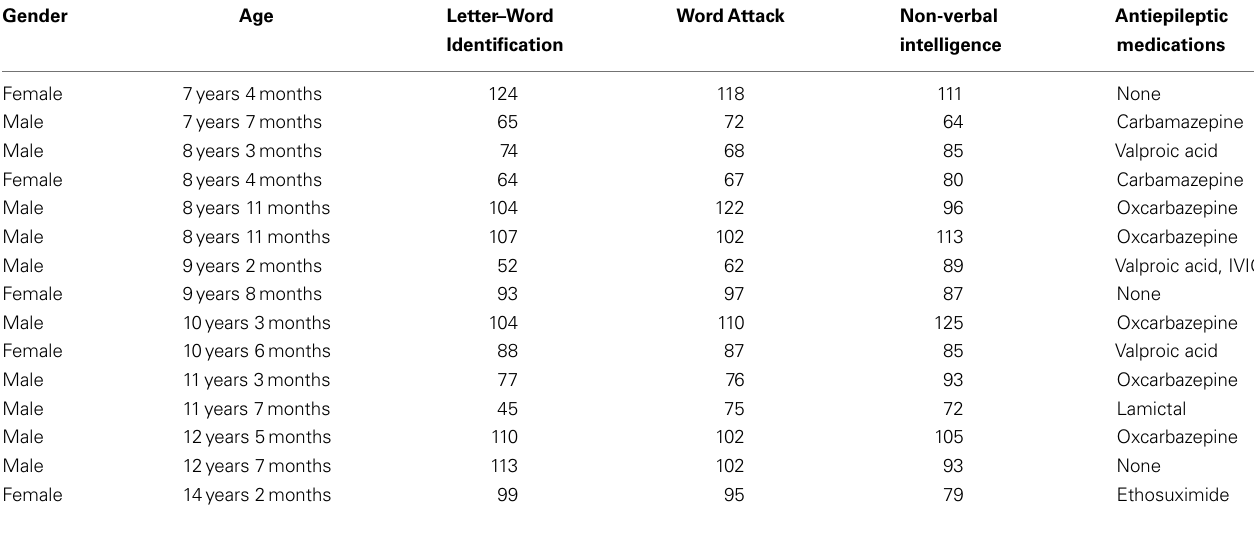
Table 2 | Specific participant scores and medications